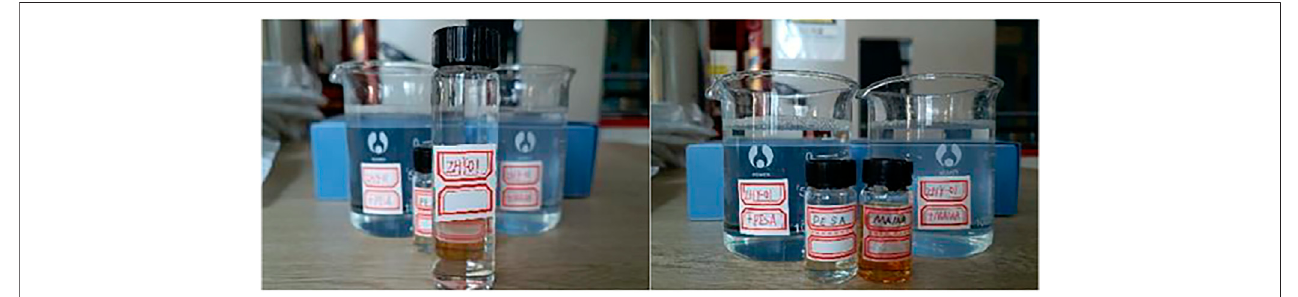
FIGURE 7 | Compatibility test of the foaming agent and scale